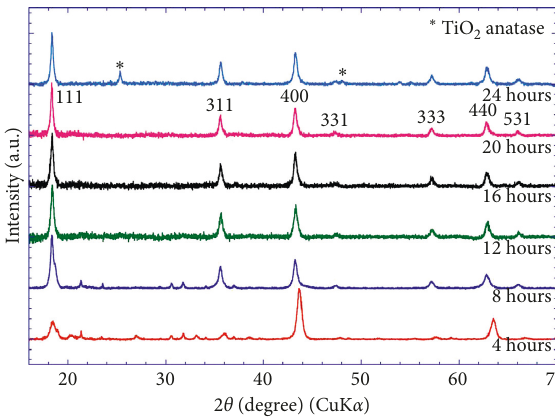
Figure 1: XRD patterns of samples at different calcination